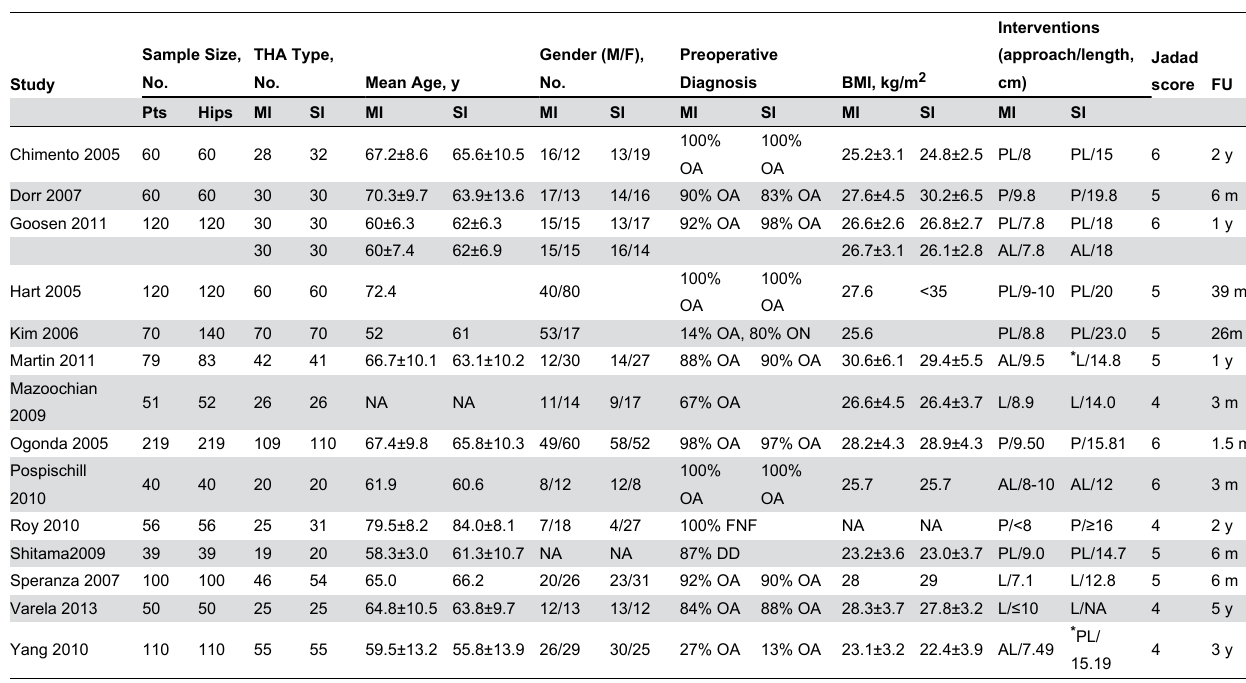
Table 1. Main characteristics of RCTs included in the